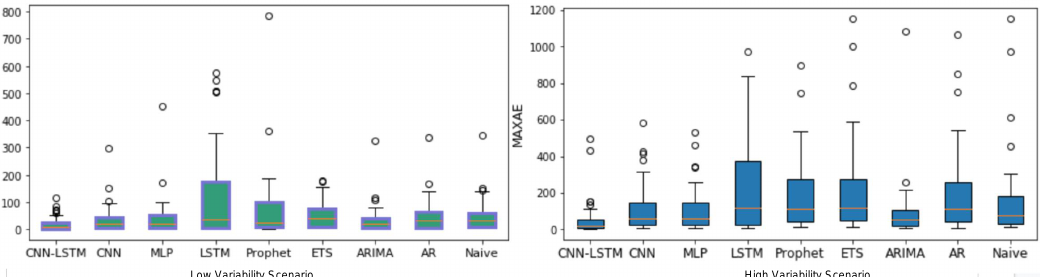
Figure 21. Each boxplot graphics indicates the distribution of MAXAE error across cells for a low and high variability scenario respectively in green and blue color. The graphics shows how deep learning methods can outperform statistical methods in a high variance